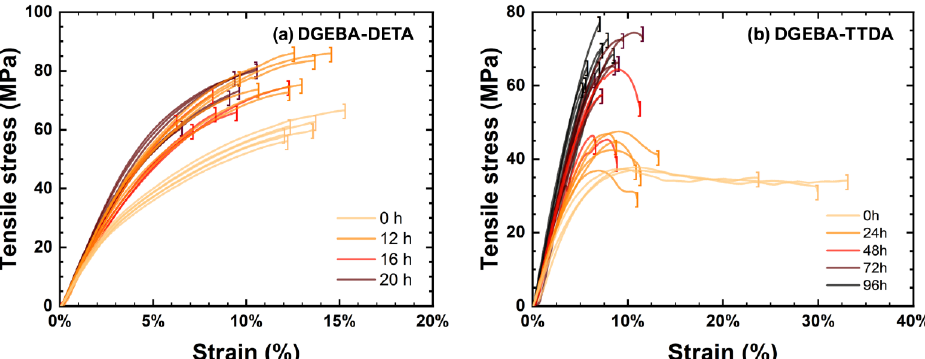
Figure 5. Typical stress-strain curves before and after several ageing durations at 160 °C for DGEBA-DETA ( a ) and DGEBA-TTDA ( b ).